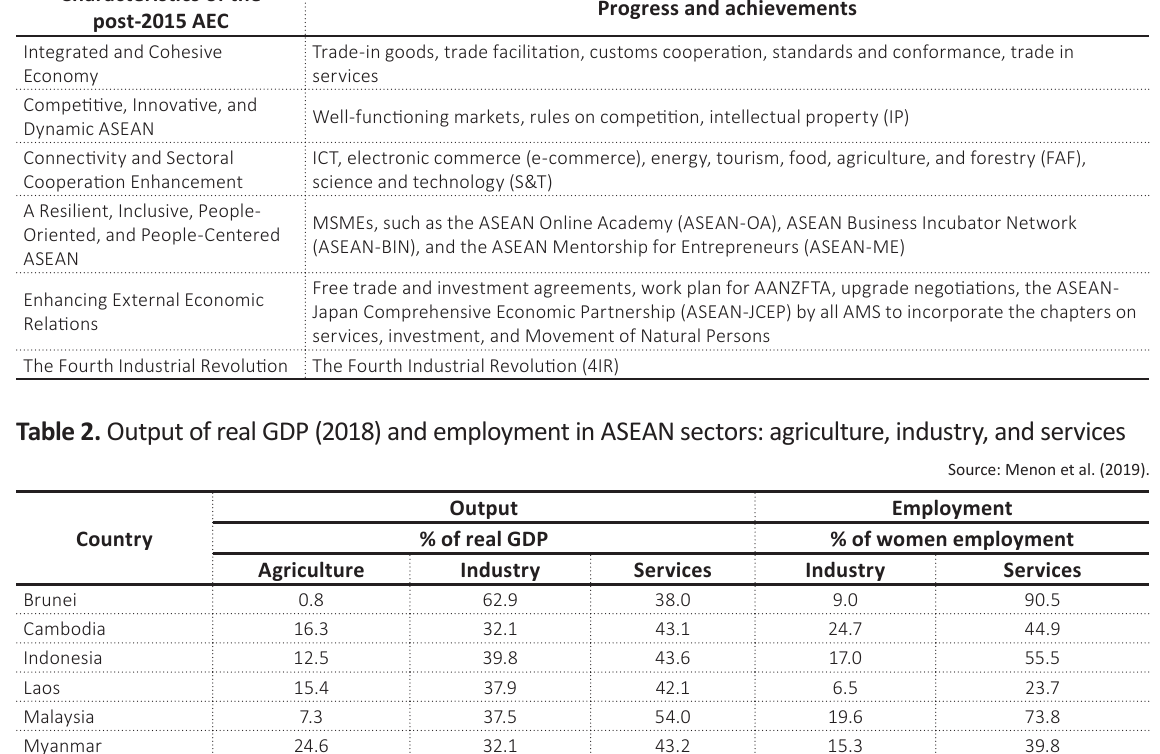
Source: ASEAN (2017).